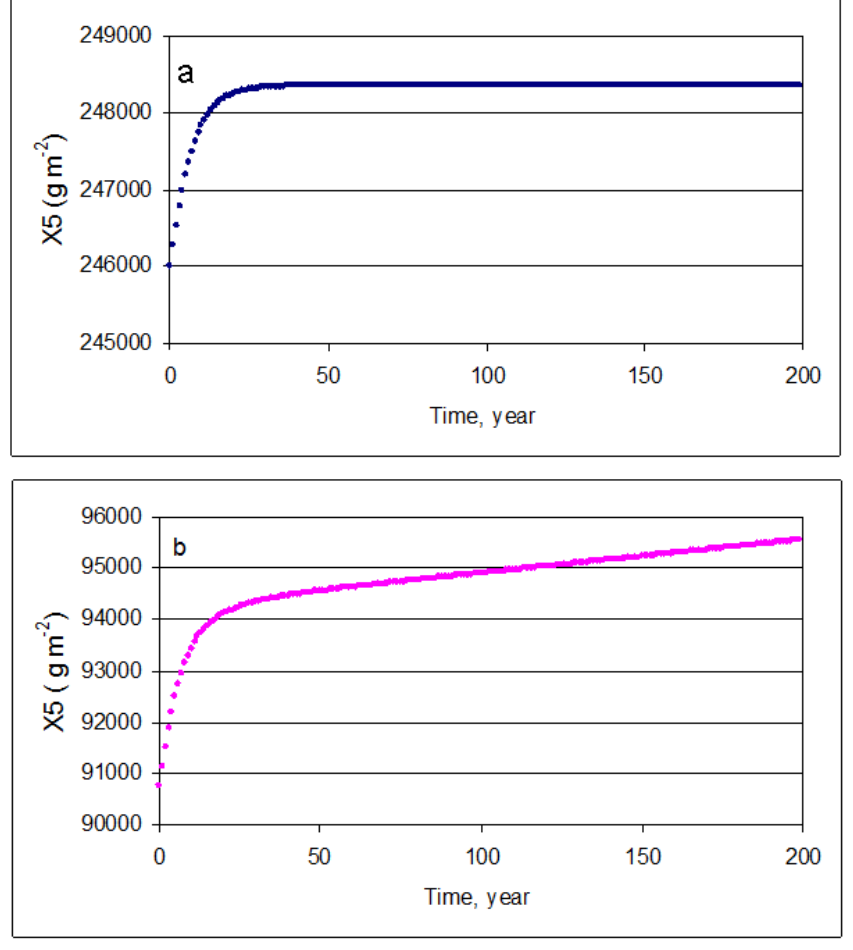
Figure 2. Time-course of X 5 cat values for PSS bog (a) and MCS fen (b). underground plant organs, 69.0 and 73.6 for